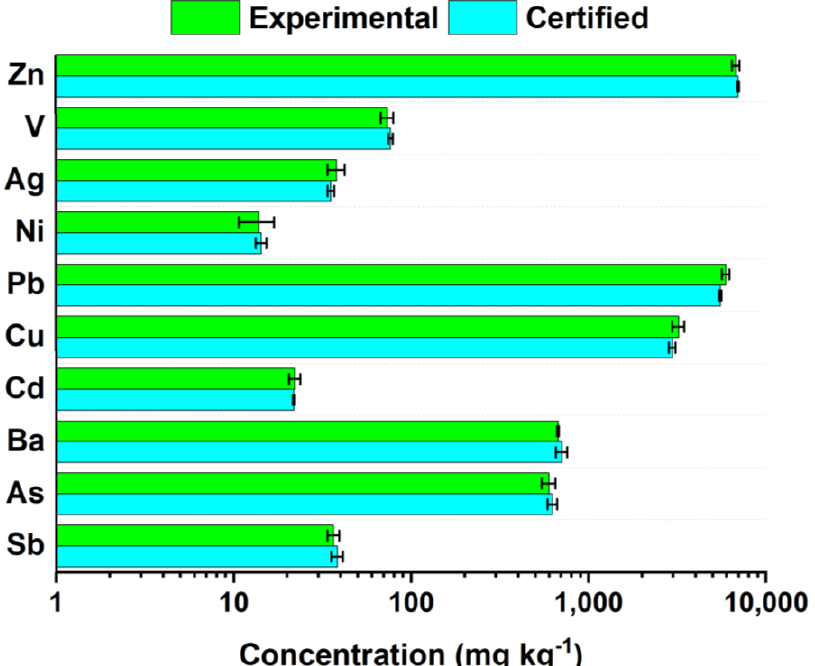
Figure 6. Comparison of certified (light blue bars) and experimental (green bars) trace elements concentrations found in NIST 2710 by applying the revised analytical protocol (pre-digestion moistening with H 2 O 2 followed by the revised MW-assisted digestion, see Figure 2b).